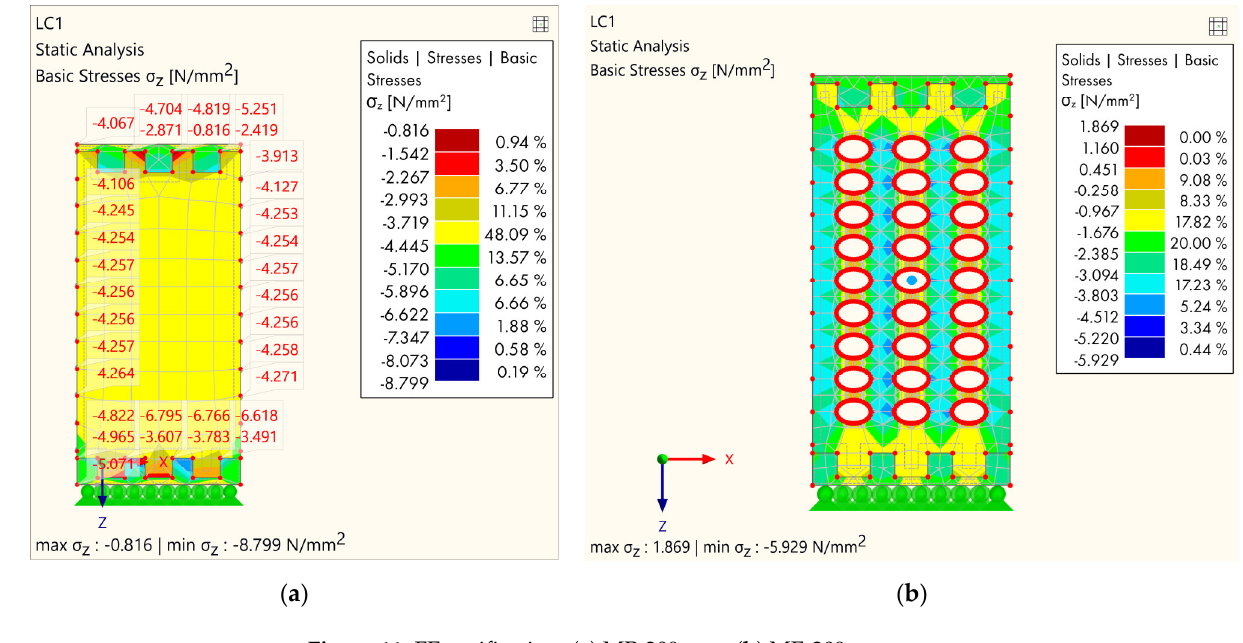
( f ) Figure 10. Failure modes characteristic for group of specimens: ( a ) ME - 209 mm; ( b ) TE - 209 mm; ( c )